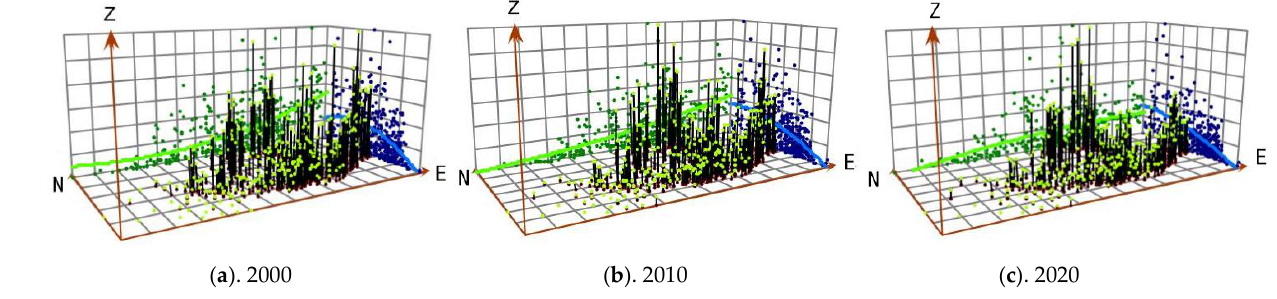
Figure 4. Distribution trends of carbon emissions in the YRB in ( a ) 2000, ( b ) 2010, and ( c ) 2020.